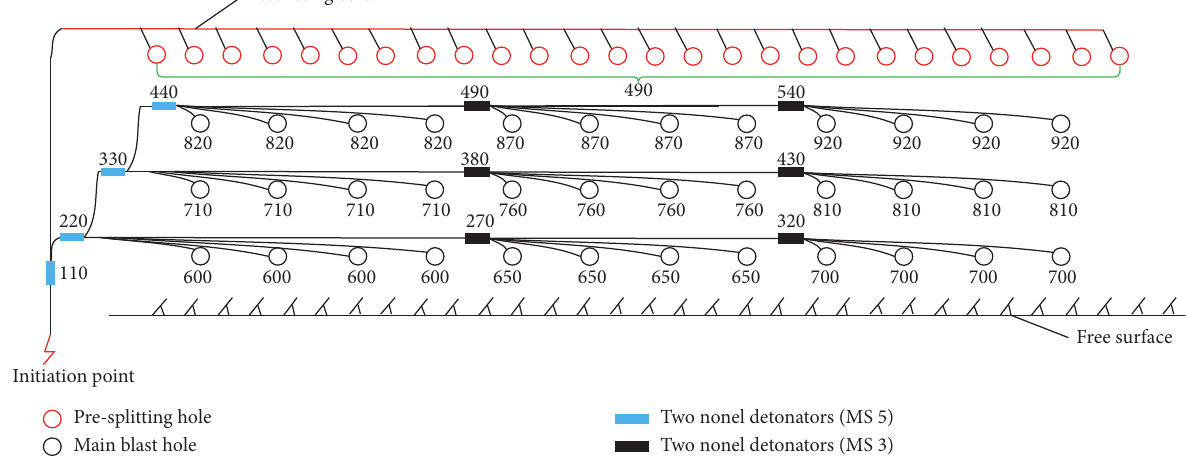
Figure 3: Schematic diagram of the arrangement of blast holes in bench blasting (each blast hole is equipped with two nonel detonators (MS10)).